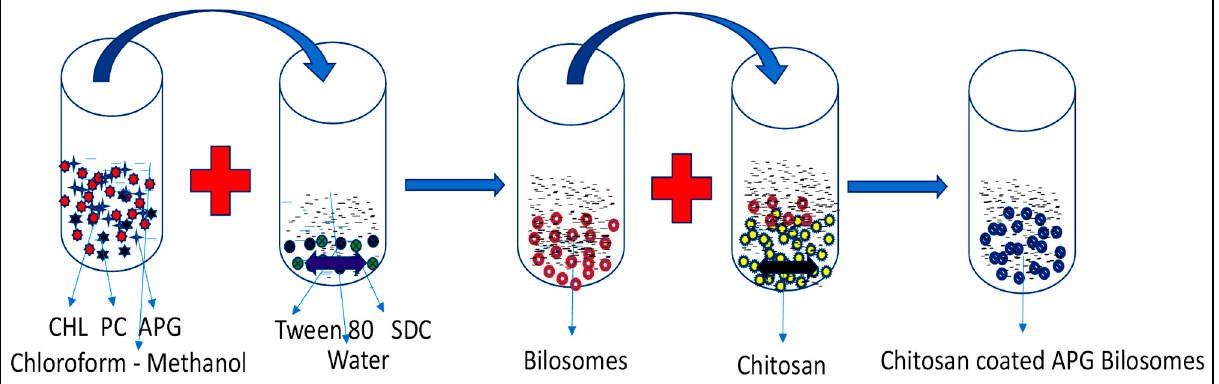
Figure 1. Schematic representation of the formulation of chitosan-coated apigenin bilosomes.